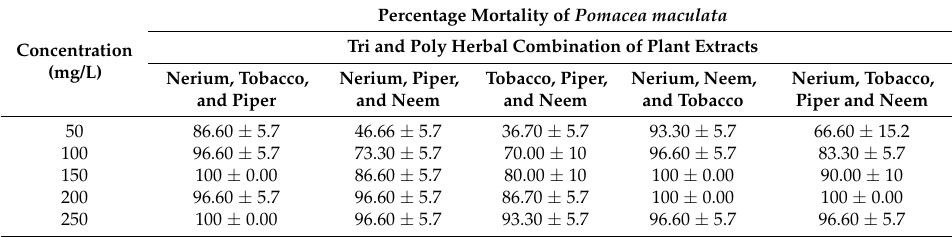
Table 6. Molluscicidal activity of tri and poly herbal combination of plant extracts on P. maculata .